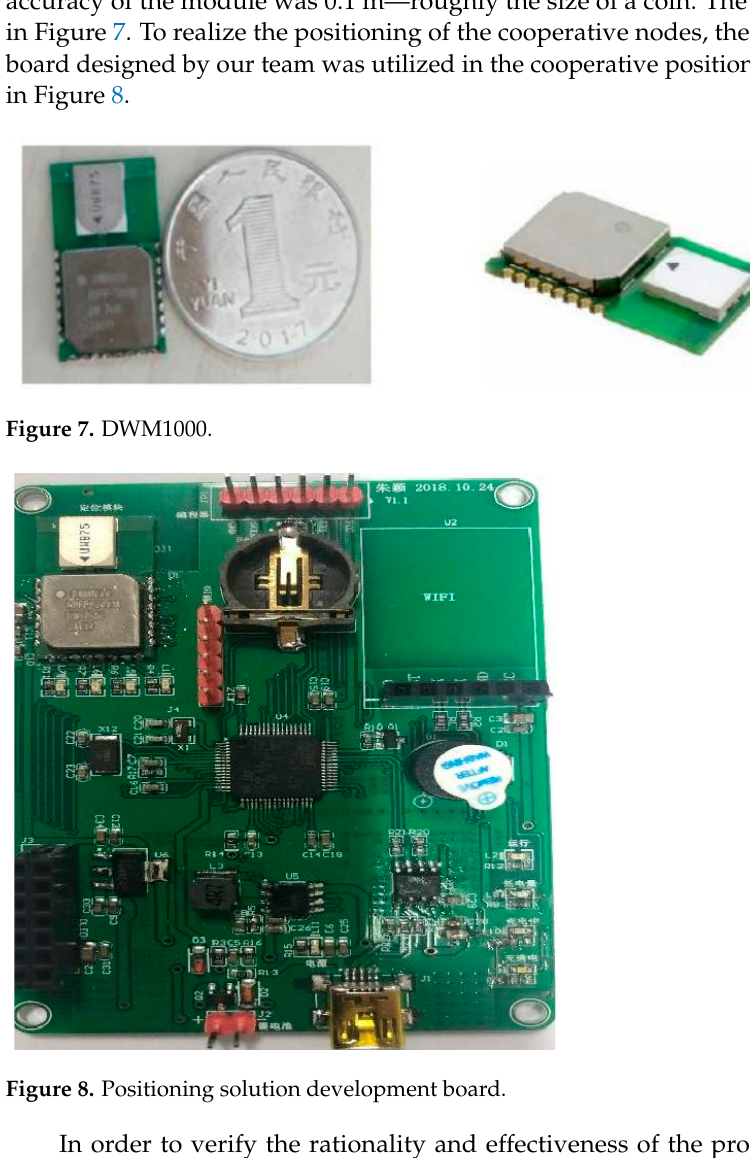
Figure 8. Positioning solution development board.